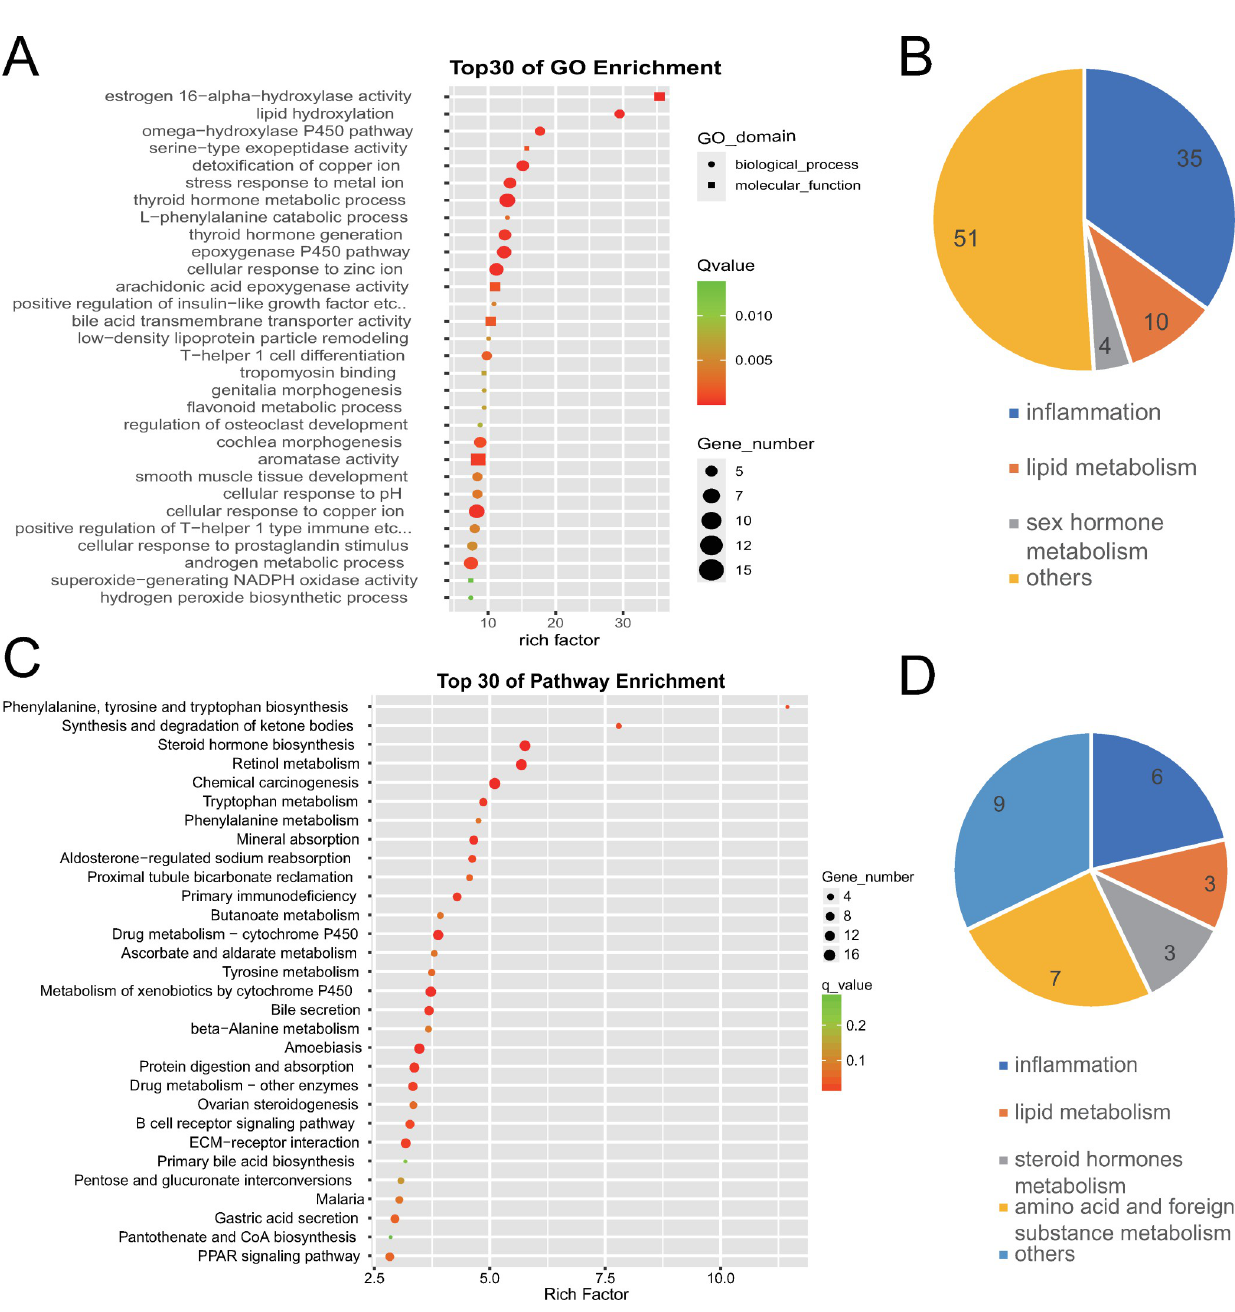
Fig 3. GO and KEGG enrichment analysis of differentially expressed mRNAs between normal gallbladders and gallbladders with chronic inflammation. (A) The top 30 GO terms with a high degree of enrichment. The shapes of icons represent different GO categories, the size of icons represents the number of differentially expressed genes contained by this GO term, the color depth represents the size of q-valueand the X axis indicates the value of the rich factor. (B) The top 100 GO terms with a larger enrichment factor were further classified. Numbers on the graph represent the number of GO terms corresponding to the category. (C) The top 30 KEGG terms with a high degree of enrichment. The size of icons represents the number of differentially expressed genes contained by this KEGG term, the color depth represents the size of q-value, and the X axis indicates the value of the rich factor. (D) The 28 KEGG terms with q-value � 0.05 were further classified. Numbers on the graph represent the number of KEGG terms corresponding to the category.